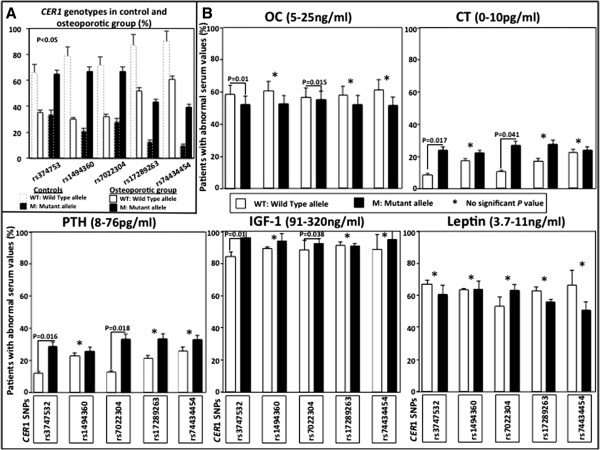
CER1 genotypes in postmenopausal women (A) and correlation with abnormal bone marker levels in osteoporotic patients (B).